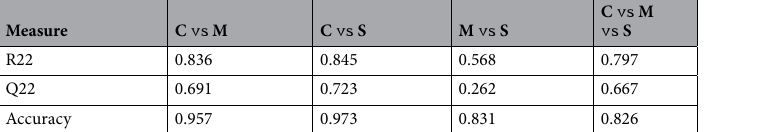
Table 3. Predictability values of partial least squares-discriminate analysis (PLS-DA). C versus M, Control versus Mild; C versus S, Control versus Severe; M versus S, Mild versus Severe; and C versus M versus S, Control versus Mild versus Severe. Q2, R2 and accuracy were calculated via double cross validation procedure with tenfold-CV, non-independent set was used.